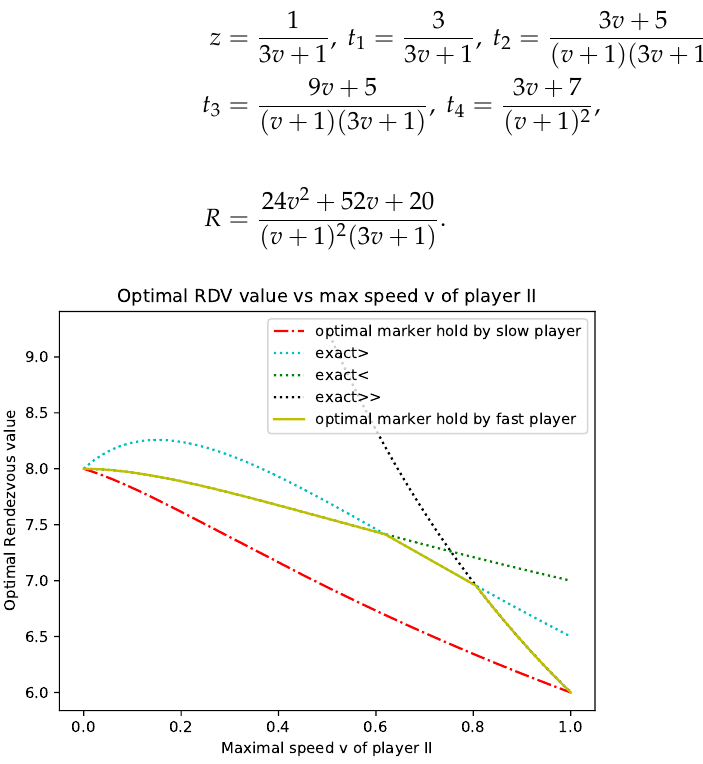
√ √ 5 − 1 ) /2, (14) for v ≥ ( 5 − 1 ) /2,